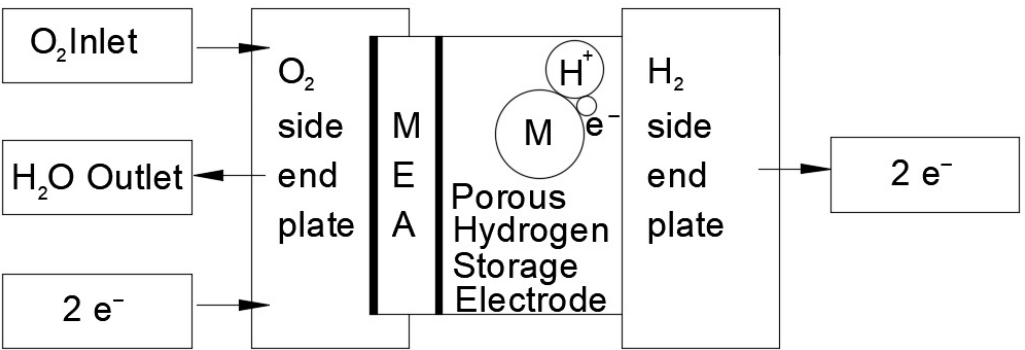
Figure 2. representing the discharging mode or fuel cell mode of the proton battery.